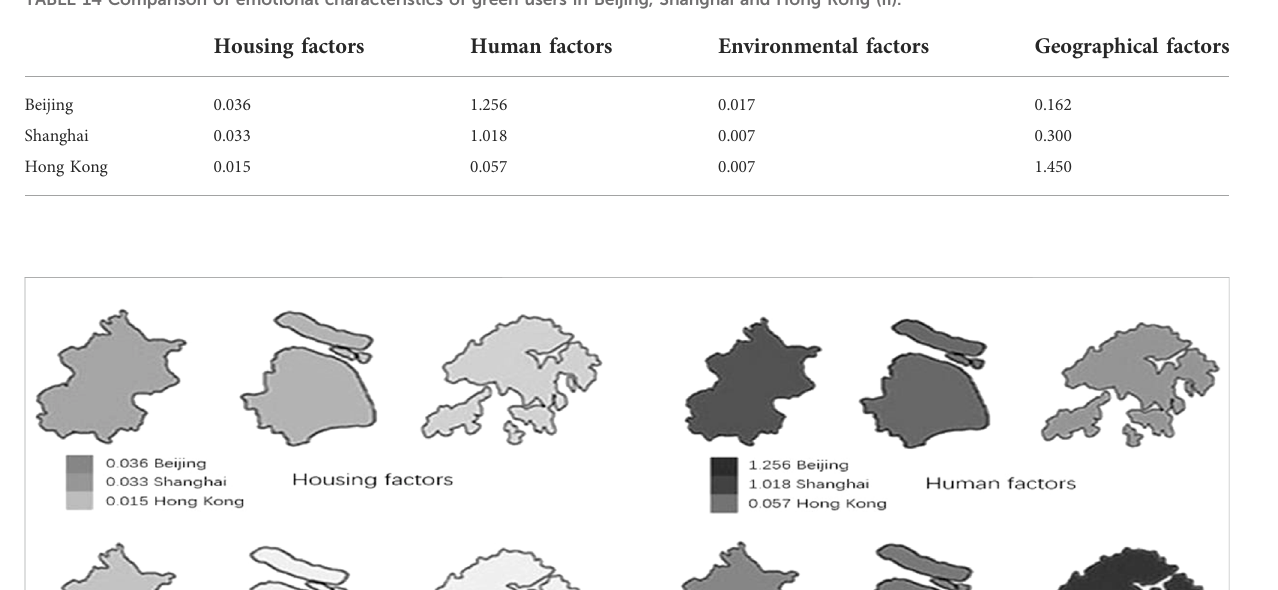
TABLE 14 Comparison of emotional characteristics of green users in Beijing, Shanghai and Hong Kong (II).